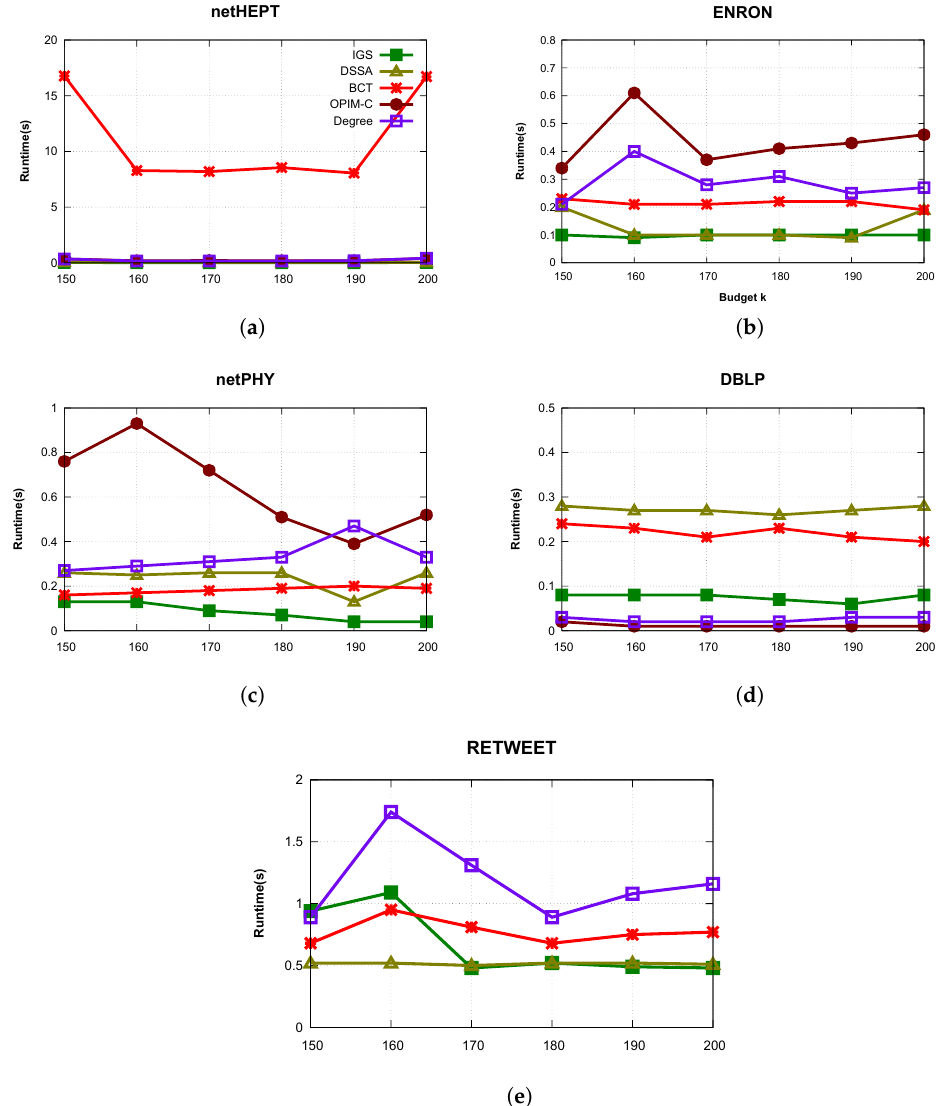
Figure 3. Comparisons about Runtime (s) with k varies from 150 to 200 between IGS and the